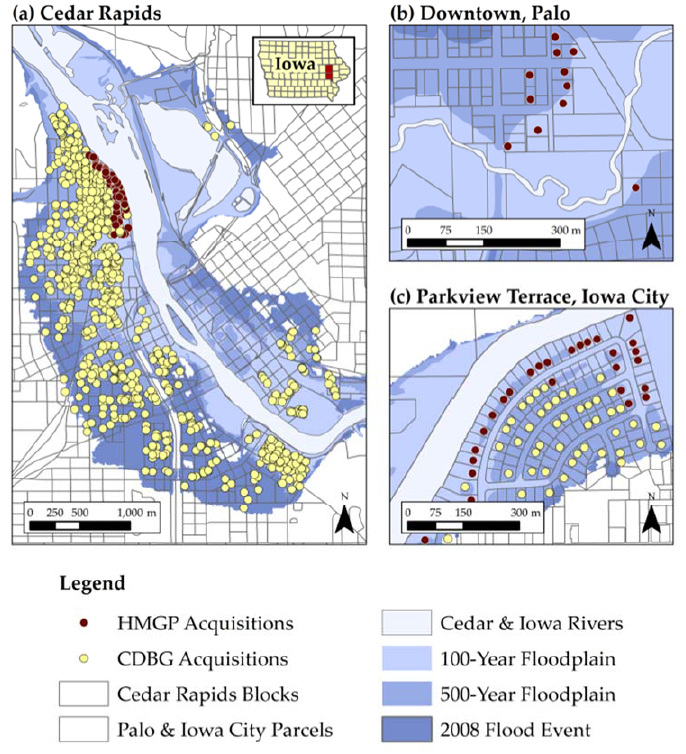
Figure 1. Spatial distribution of residential property acquisitions by city: ( a ) Cedar Rapids; ( b ) Downtown, Palo; ( c ) Parkview Terrace, Iowa